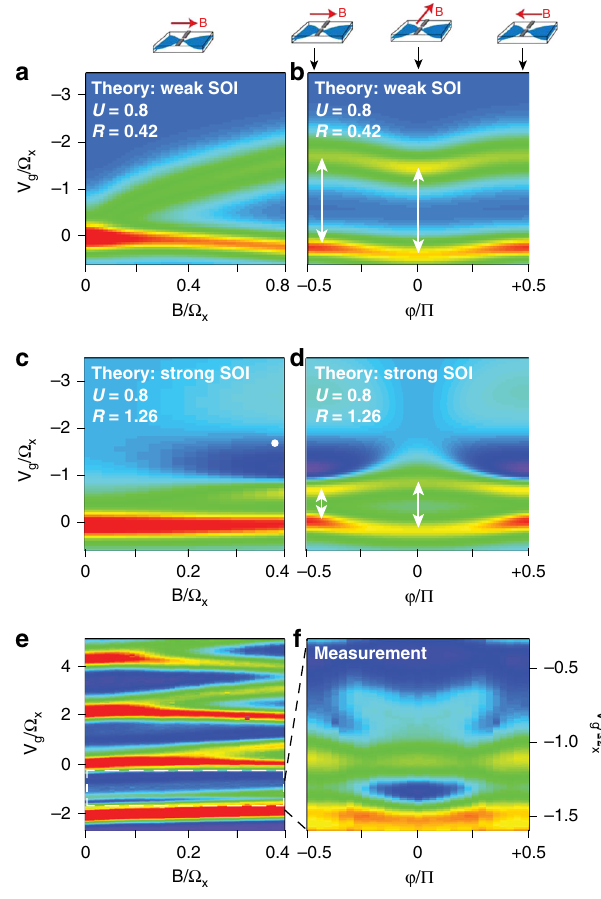
Fig. 4 Transconductance of a QPC in magnetic fi eld with spin – orbit and many-body interactions. a Calculated transconductance of fi rst 1D subband with small Rashba SOI R ¼ 0 : 42 in increasing magnetic fi eld up to B / Ω x = 0.8. b Calculated transconductance of the fi rst 1D subband with small R ¼ 0 : 42 as a function of magnetic fi eld angle φ where the magnitude of the magnetic fi eld is fi xed at B / Ω x = 0.8. The width of the energy gap between the two transconductance peaks is indicated by the white arrows. c Calculated transconductance of fi rst 1D subband with strong R ¼ 1 : 26 (abbreviated from Fig. 3j) in increasing magnetic fi eld up to B / Ω x = 0.4. The white dot indicates the region corresponding to the spin gap conductance minima in the vicinity of B / Ω x = 0.4. d Calculated transconductance of the fi rst 1D subband with small R ¼ 1 : 26 as a function of magnetic fi eld angle φ where the magnitude of the magnetic fi eld is fi xed at B / Ω x = 0.4. The width of the energy gap between the two transconductance peaks is indicated again by white arrows. e Measured transconductance of fi rst 1D hole subband (abbreviated from Fig. 3b) in increasing magnetic fi eld up to B = 4 T. f Measured transconductance of the fi rst 1D hole subband as a function of magnetic fi eld angle φ where the magnitude of the magnetic fi eld is fi xed at B = 4